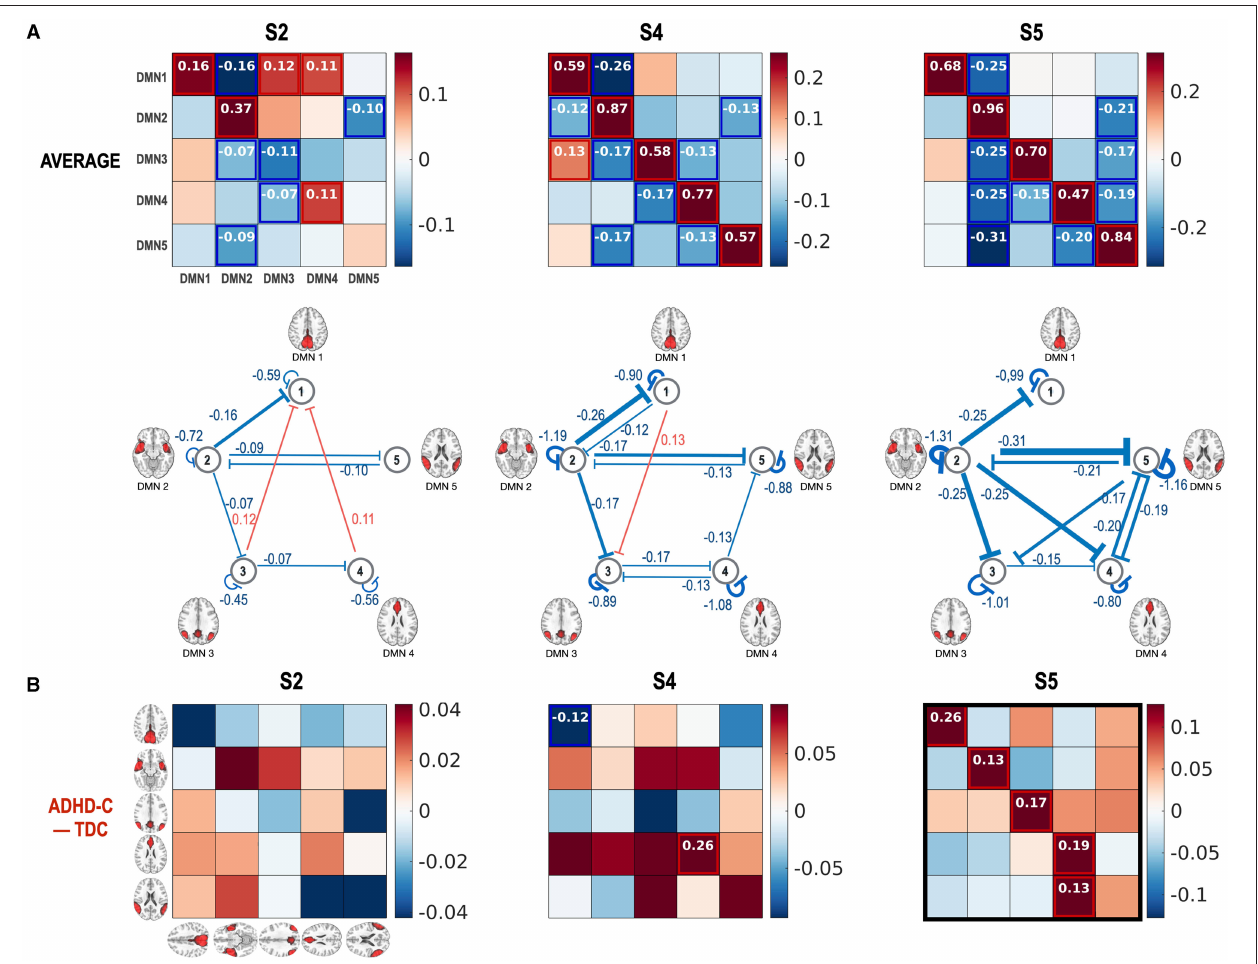
FIGURE 7 | Group PEB results for the state-dependent effective connectivity. Group-level state-dependent effective connectivity matrices, and their connection maps were displayed for connectivity states S2, S4, and S5. A fixed-effects model (concatenating all DCMs for all children) was used for all the subjects (both ADHD-C and TDC) using PEB. The fixed-effect models for ADHD-C and TDC’s spDCMs were hierarchically modeled with group common (average) (A) and group difference (B) design matrix using an additional PEB analysis step. We found none or few group differences in the effective connectivity at the states S2 and S4 while stronger self-inhibition was found in the ADHD-C compared with TDC in the state S5. The colors in the rectangular matrix represent the MAP for the connectivity from the column element to the row element. The diagonal term in the rectangular matrix should be interpreted after a transformation of − 0.5 exp(A ii ), to constrain the diagonal term for the self-connectivity to be inhibitory. For clarity, diagonal elements are displayed with transformed values in the network diagram in the second row of (A) . Effect sizes that survived a criterion of 95% posterior confidence are shown in numbers and